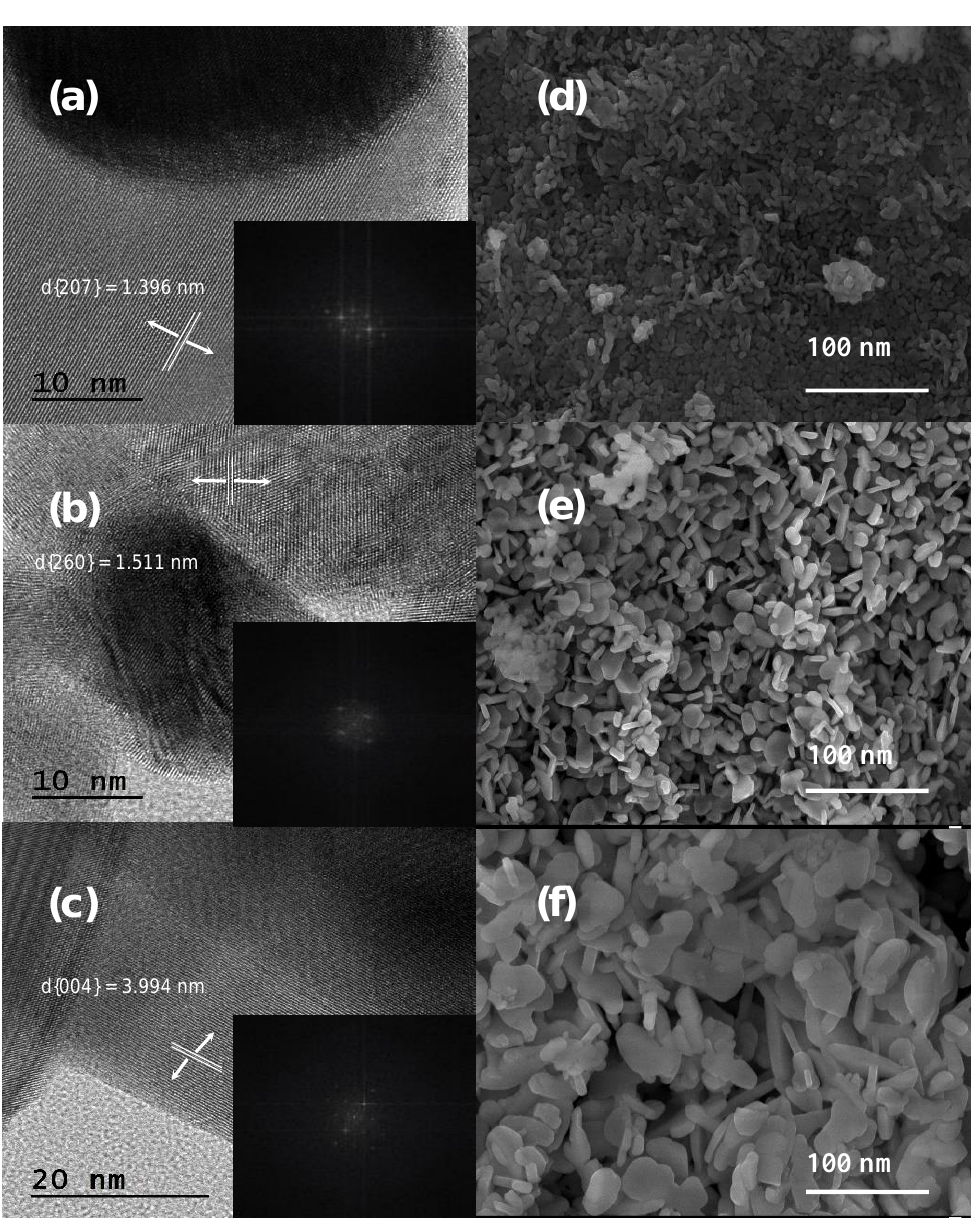
Figure 3. High-resolution transmission electon microscopy (HR-TEM) images of ( a – c ) PL-12h, HL-12h, and PL-6h, and FE-SEM images of ( d – f ) PL-12h, HL-12h, and PL-6h. The insets of ( a – c ) show their fast Fourier transform patterns.